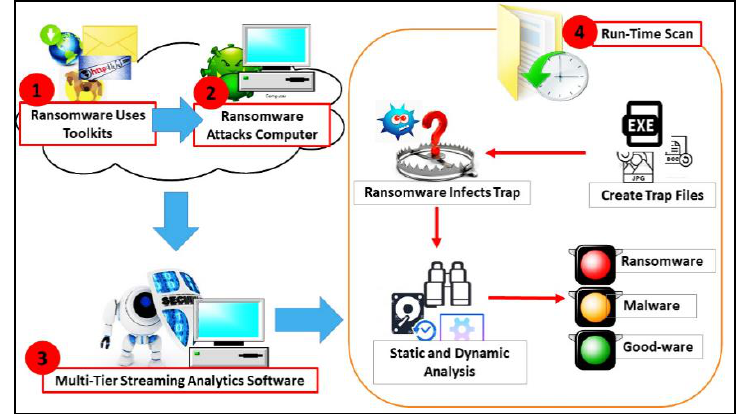
Figure 5. The run-time test routine of the multi-tier streaming analytics model.